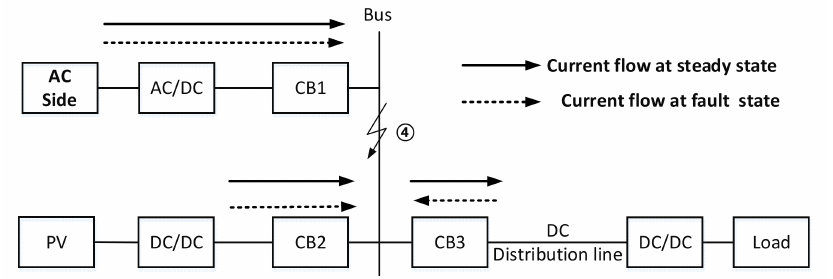
Figure 5. Comparison of the current flow in the steady state and in a fault in section 4 (cid:13)